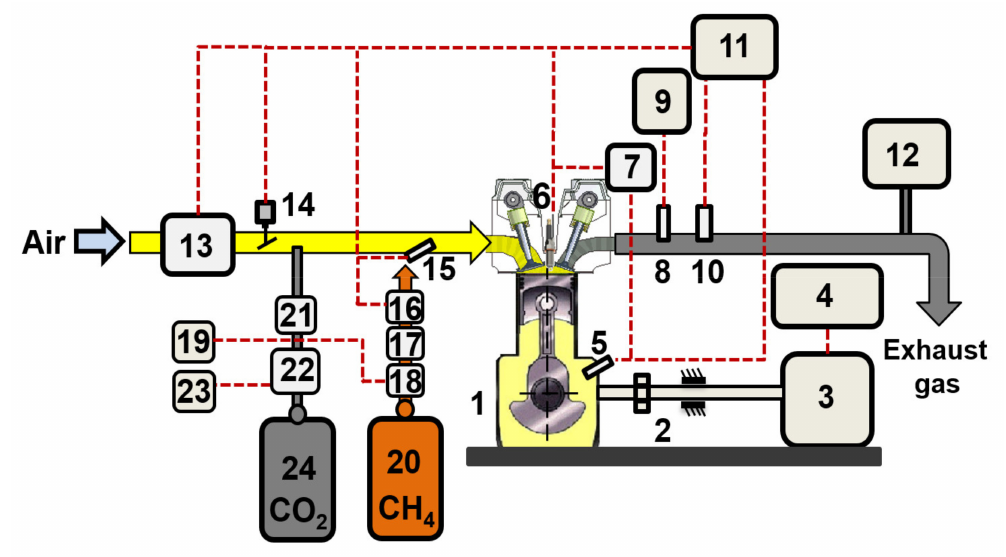
Figure 2. Experiment setup. 1—HR16DE SI engine; 2—connecting shaft; 3—engine load stand; 4—load stand ECU and display; 5—crankshaft position sensor; 6—spark plug with pressure sensor; 7—in-cylinder pressure recording equipment; 8—exhaust gas temperature sensor; 9—exhaust gas